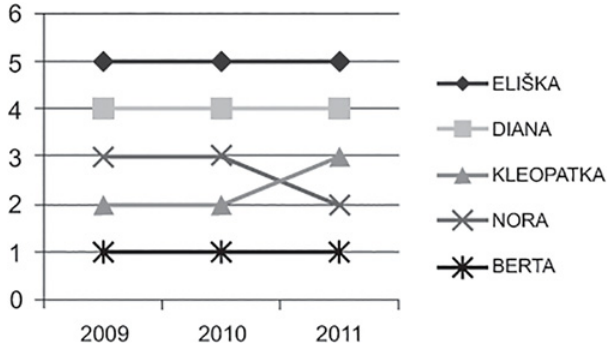
Fig 3. Rank stability. Changes in the CBI rank of five adult females during three consecutive years in the combined herd in Prague.